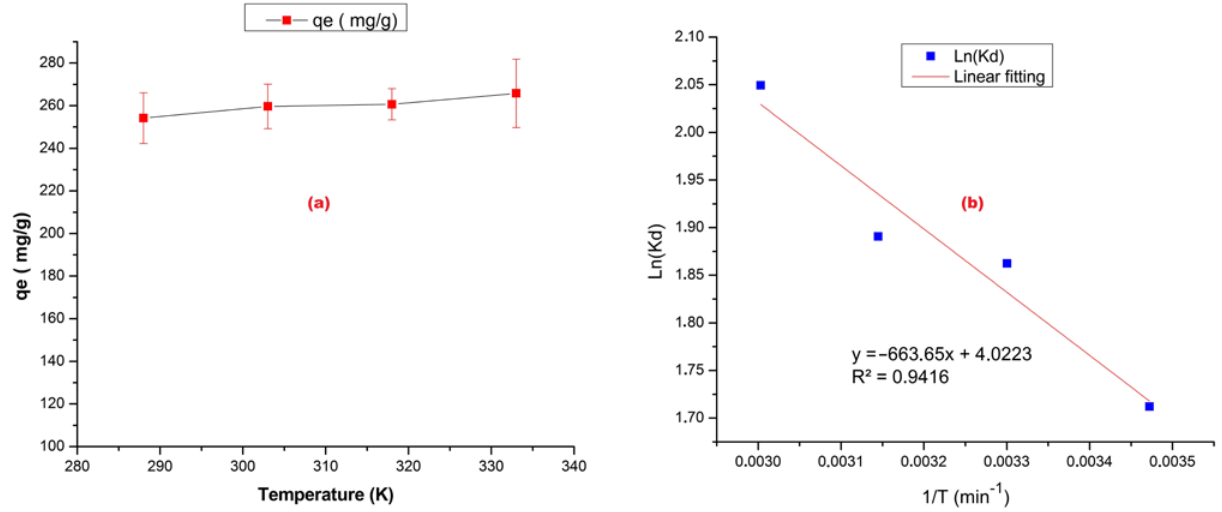
Figure 12. Effect of temperature on the adsorption of TA by steel slag (C 0 = 300 mg/L; m = 100 mg; V = 100 mL; pH = 6.6 ± 0.1; time = 225 min; Agitation = 500 rpm) ( a ), adsorption thermodynamic for the TA adsorption by steel slag ( b ).